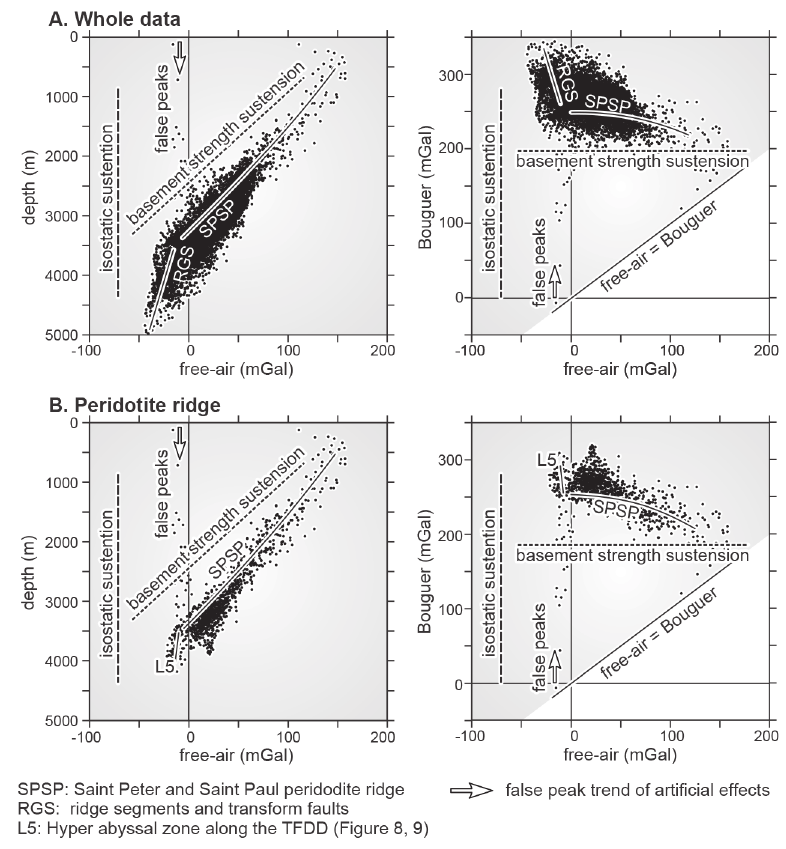
Figure 11 - Satellite-derived topographic and gravimetric data projected on the gravi- metric interpretation diagrams: A) Whole studied area; B) Around Saint Peter and Saint Paul peridotite ridge. The data area for diagram B is indicated by Figure 1 as Area